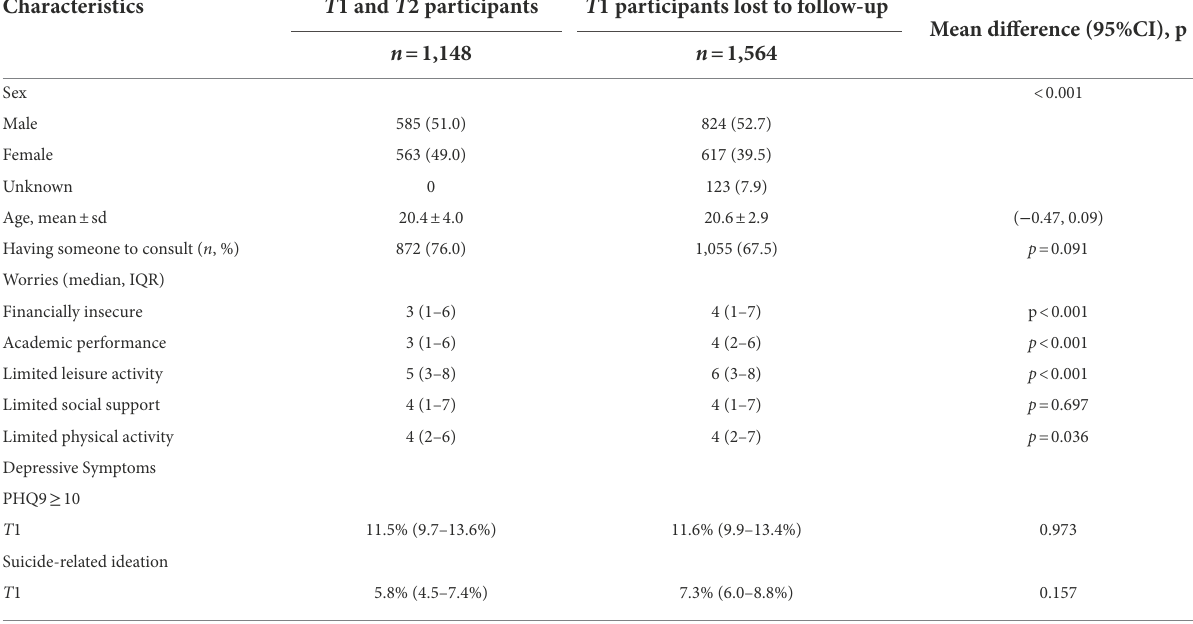
TABLE 1 Demographics of T 1 (during first wave of the pandemic in May–June 2020) and T 2 (March–May in 2021) participants ( n = 1,148) and participants lost to follow-up ( n = 1,564).